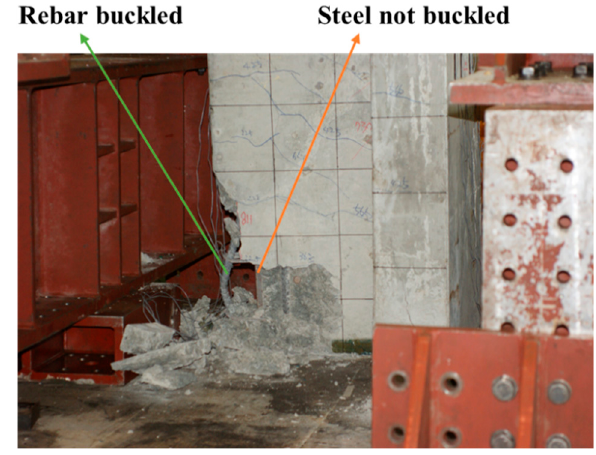
Figure 3. Rebars buckled during beam testing [17].